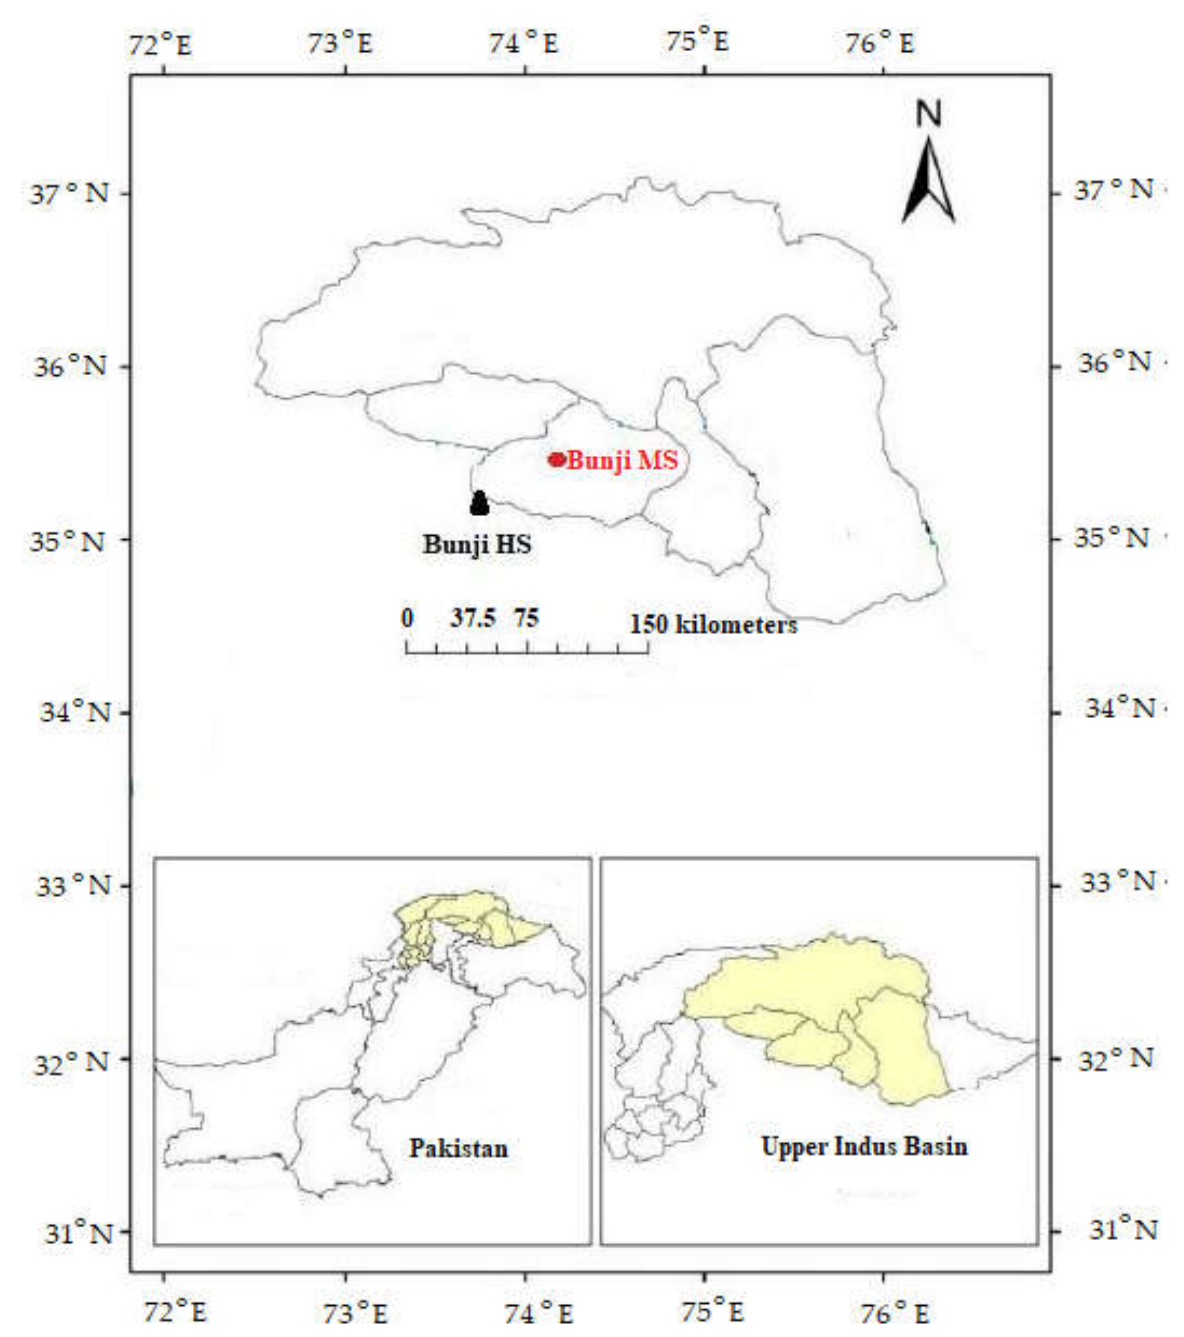
Figure 1. Location map of selected stations.